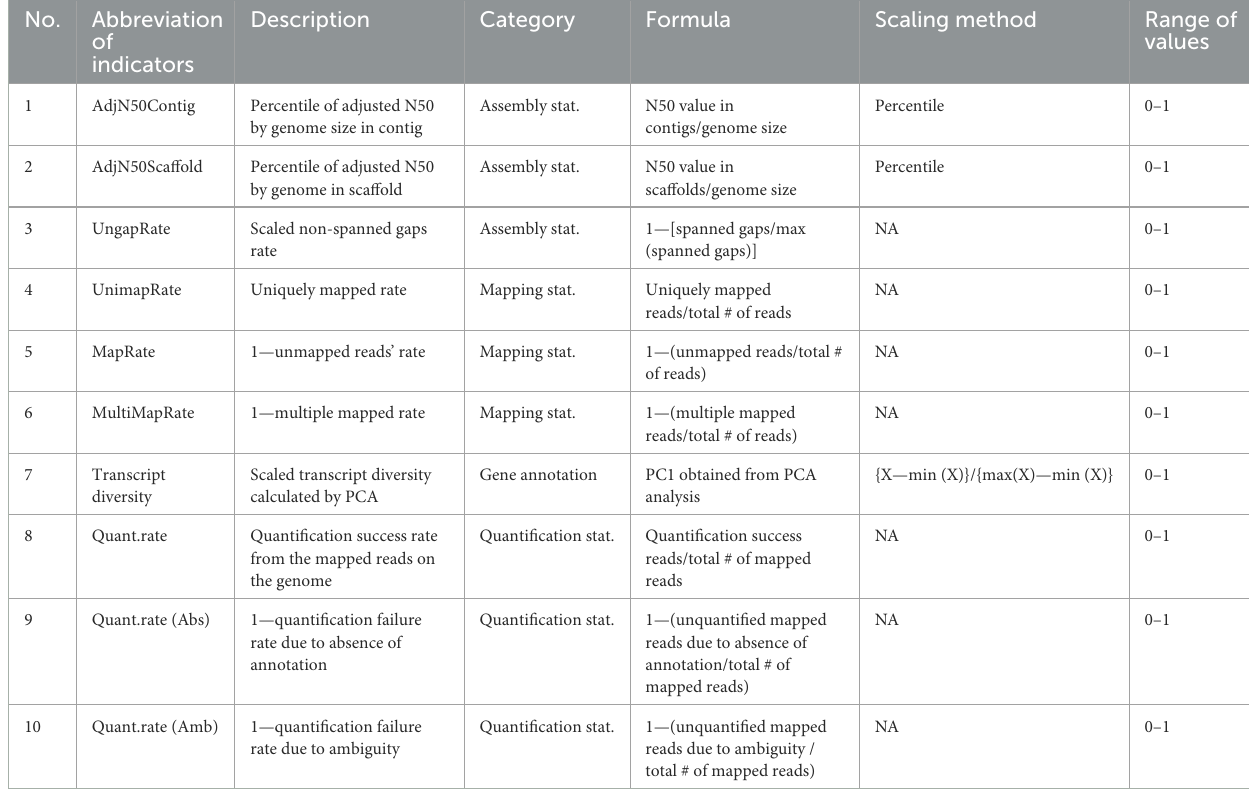
TABLE 1 Selected 10 indicators for quality evaluation of reference genome and gene annotation in diverse